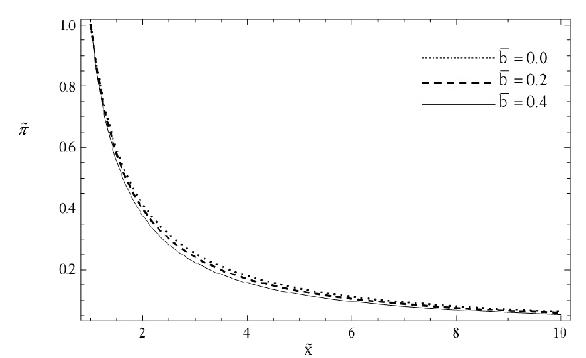
Figure 1. The decay behavior of shock strength ( 0 . 5 and γ = 5/3.